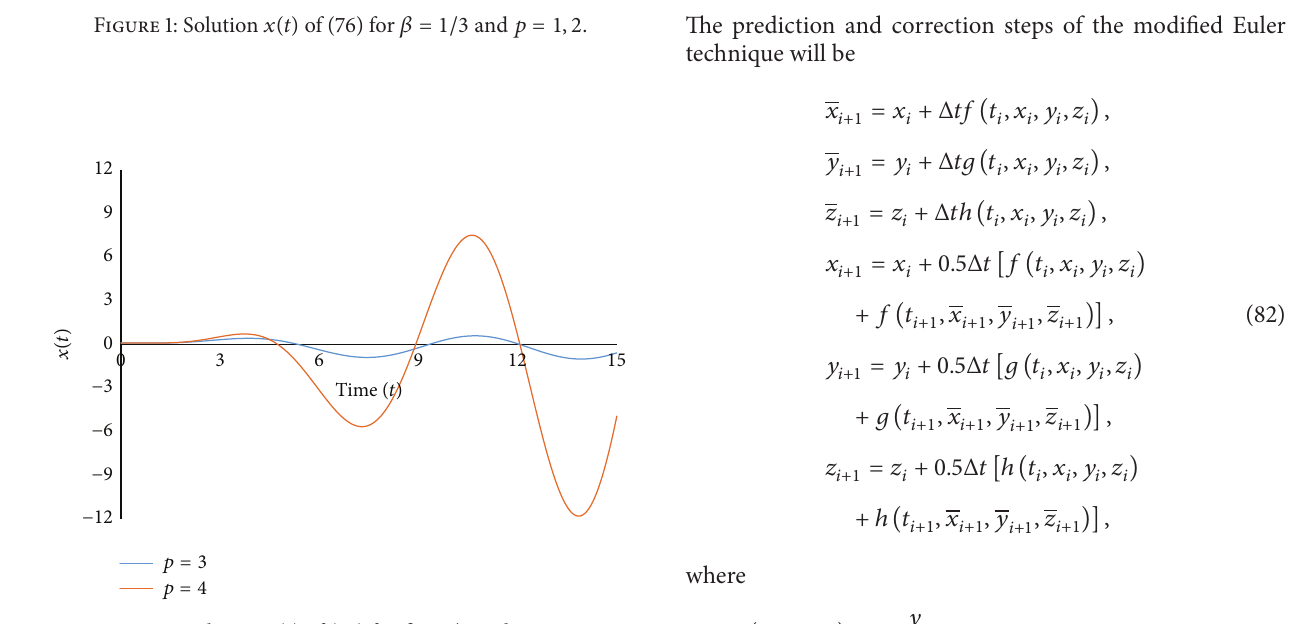
Figure 2: Solution 𝑥(𝑡) of (76) for 𝛽 = 1/3 and 𝑝 = 3,4 .